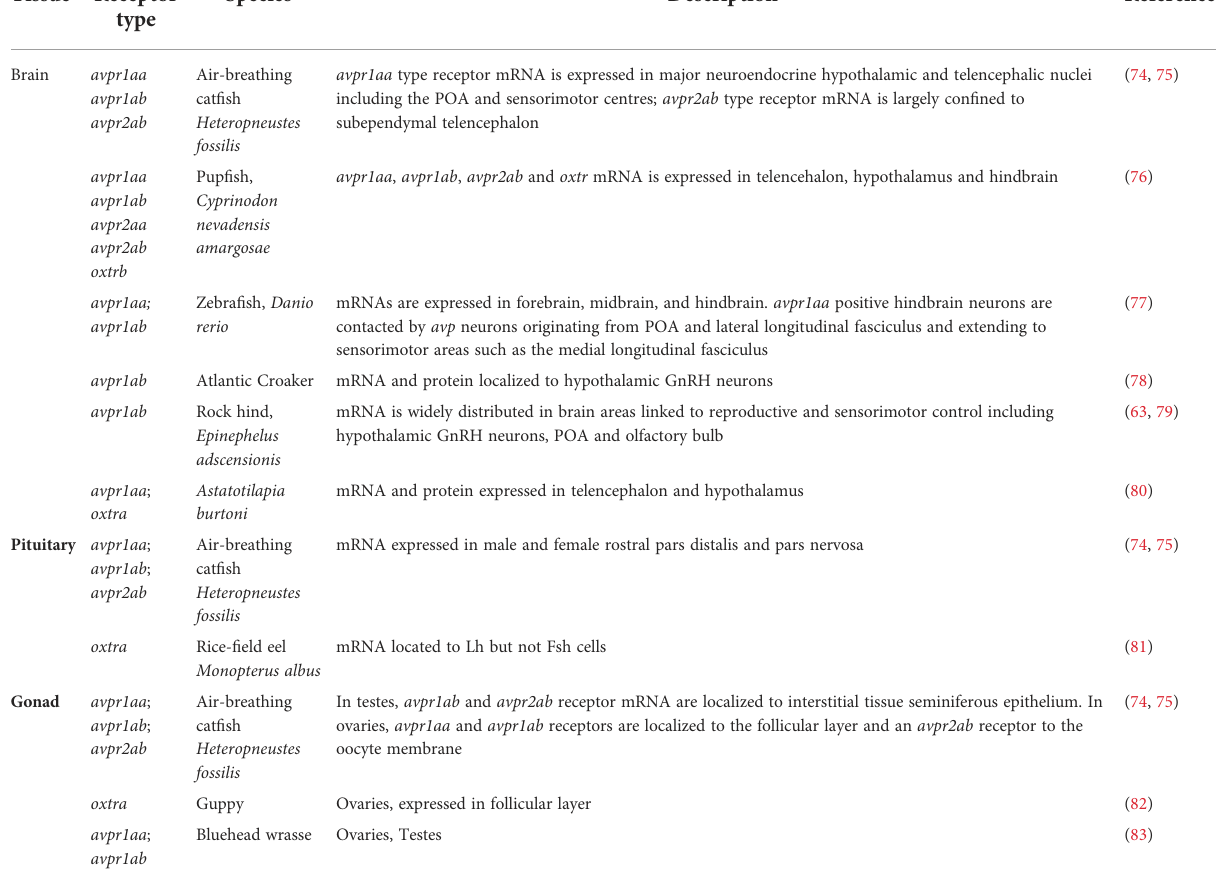
TABLE 3 Nonapeptide receptor expression in central and peripheral teleost tissues relevant to reproduction. Tissue Receptor